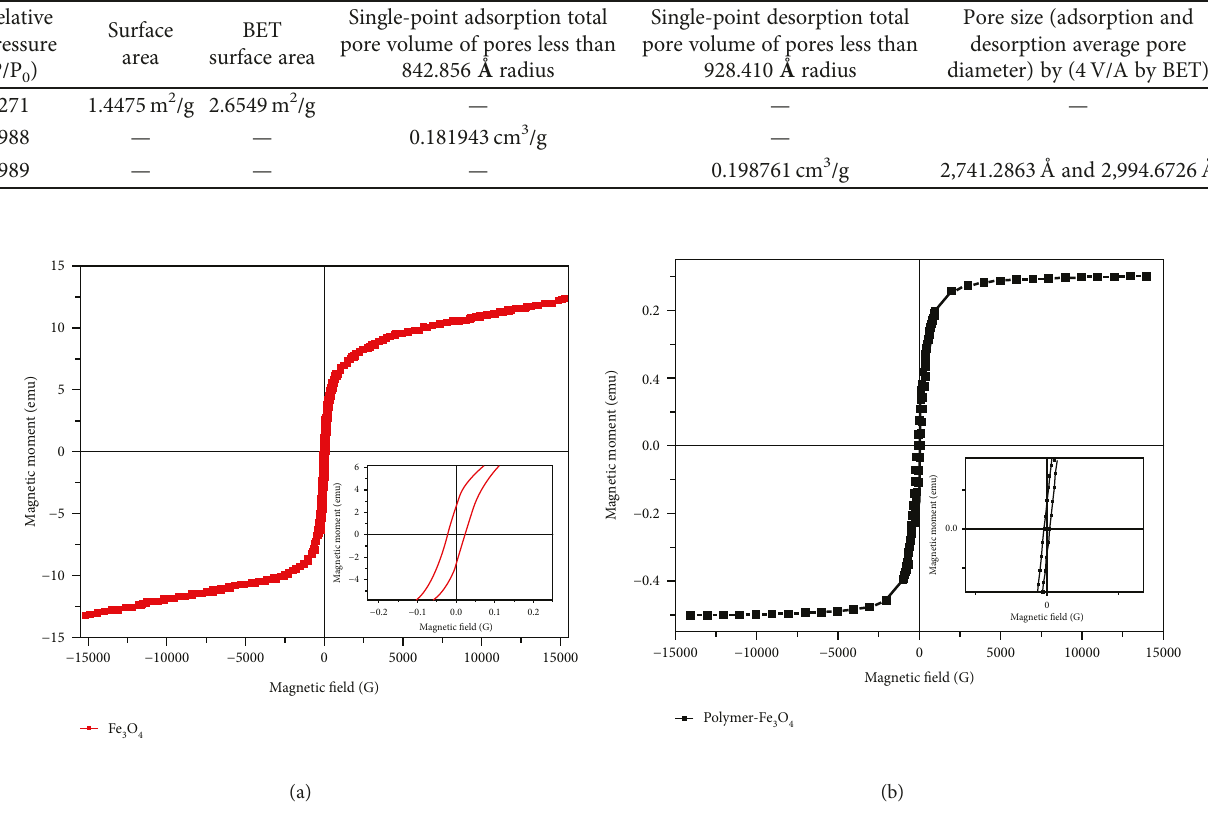
-cyclohexylidene bisphenol oxalate)-MCC- ̲